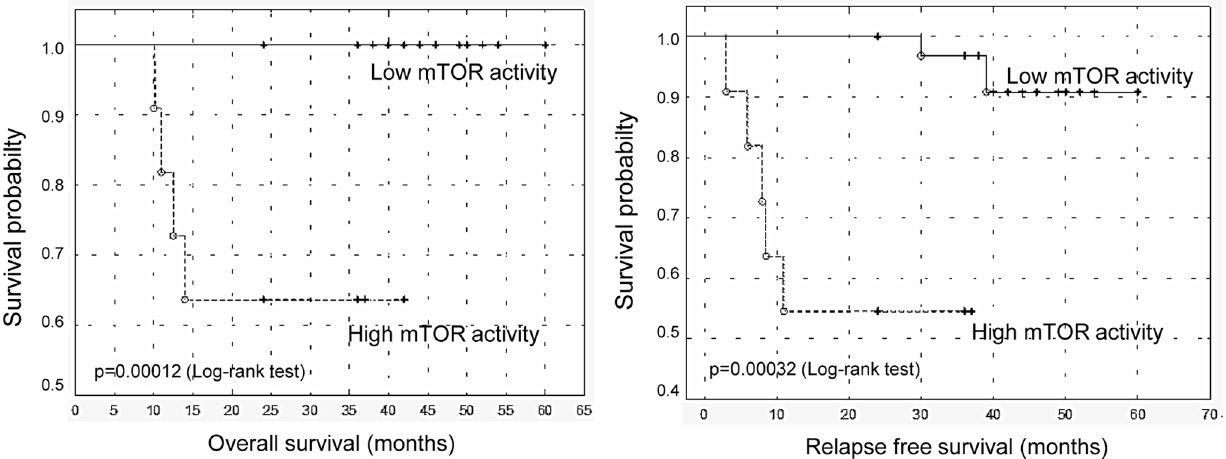
Figure 3. Survival analysis (Kaplan-Meier curves). Kaplan-Meier curves show overall and relapse free survivals for patients (n=49) stratified by mTOR activity. Cutoff value between low and high mTOR activity groups (n=37 and n=12, respectively) was determined to be 1.1 for p-4EBP1 ODs (ELISA). We found that patients with low mTOR activity had significantly longer overall and relapse free survival (P ,, 0.05 with log-rank test; o: complete event, + : censored cases).